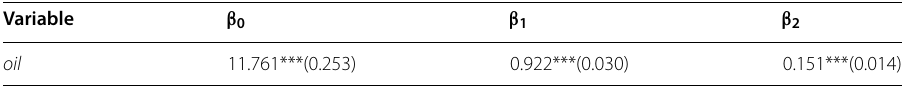
Table 1 Estimated coefficients of the GARCH (1,1) model